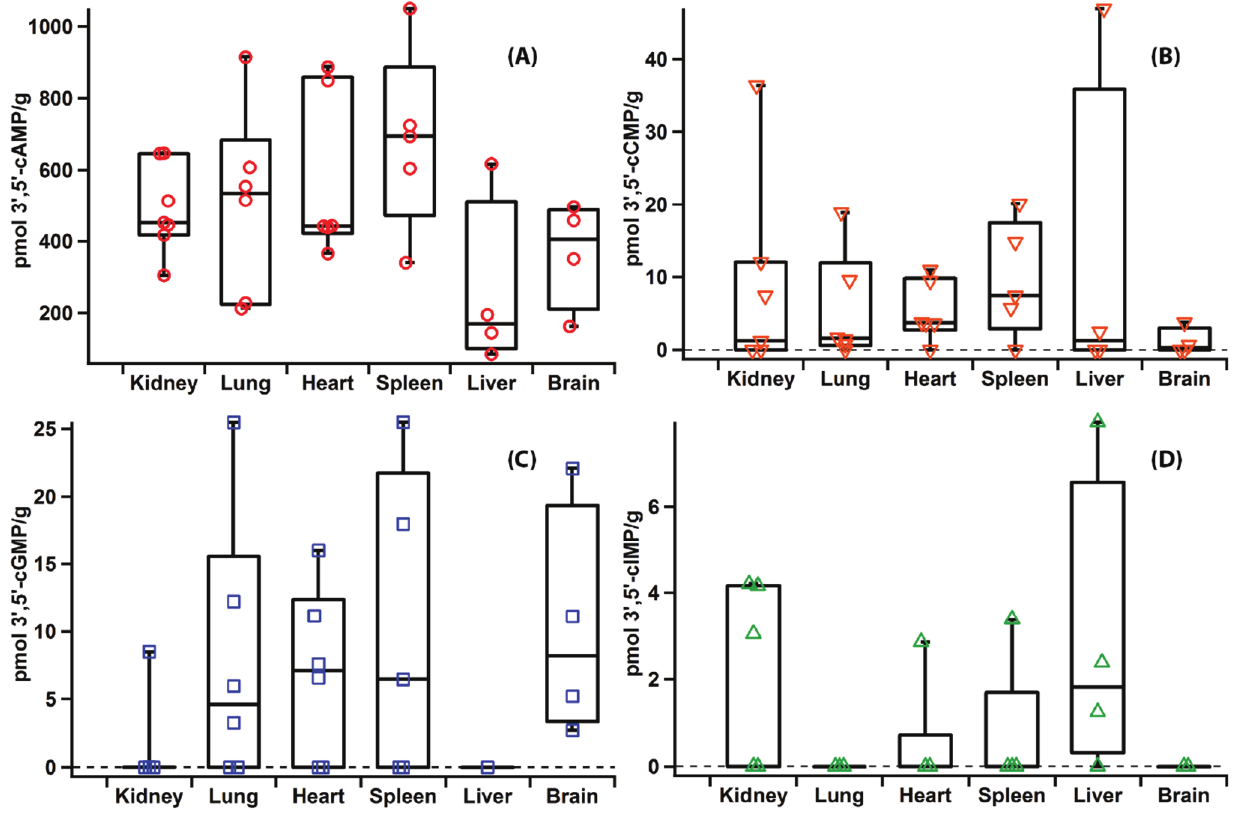
Figure 6. Levels of extracted 3',5'-cNMPs (pmol/g wet tissue) in rat organs. Each point represents the level measured in a replicate from a different rat. ( A ) 3',5'-cAMP ( B ) 3',5'-cCMP ( C ) 3',5'-cGMP ( D ) 3',5'-cIMP. Whisker top: 90 percentile, box top: 75 percentile, box middle: 50 percentile, box bottom: 25 percentile and whisker bottom: 10